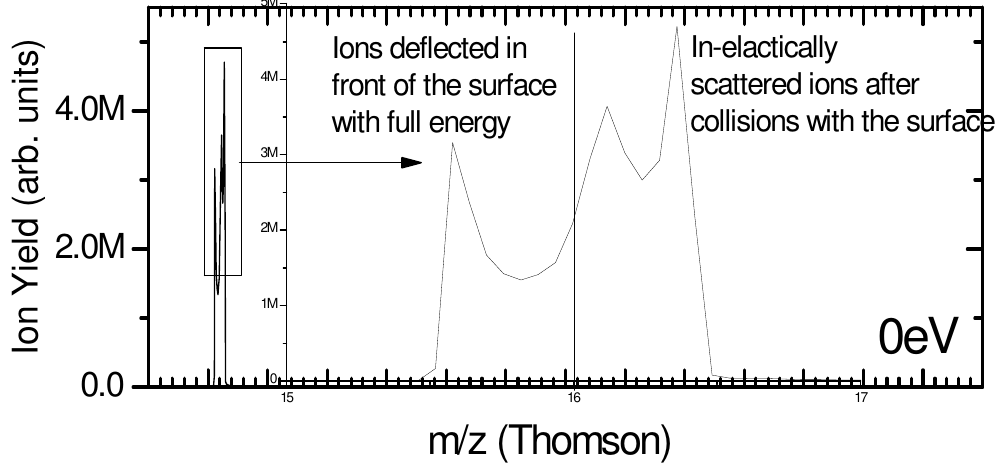
FIG. 2. SECONDARY ION MASS SPECTRUM (SIMS) OF CD 2+ COLLIDING WITH A PLASMA SPRAYED TUNGSTEN (PSW) SURFACE AT E IN = 0